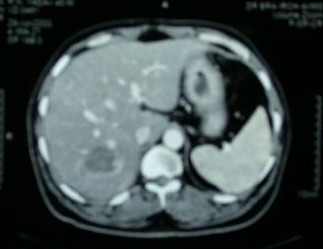
Post radiofrequency ablation CT scan image showing complete resolution of hepatic metastasis.